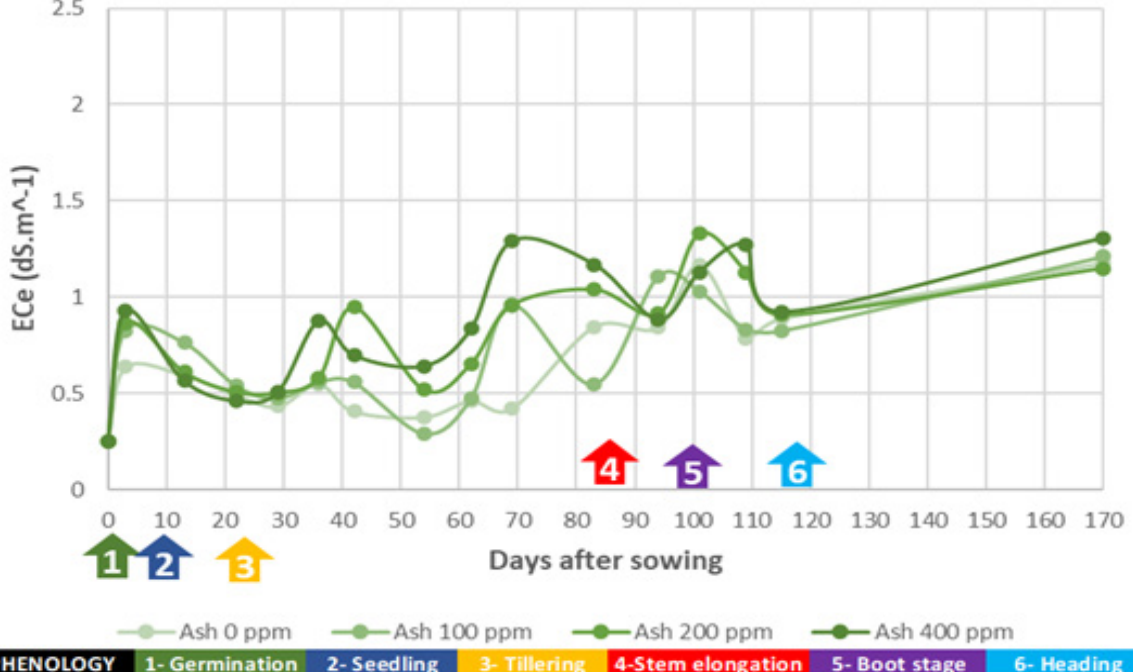
Figure 1 . Fluctuation of ECe ( dS.m - 1 ) for all rice husk ash treatments (Ash Xppm) during the field stage of the